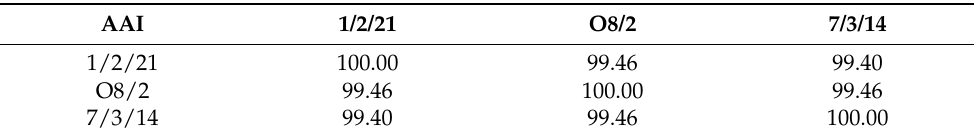
Table 4. Pairwise Average Amino Acid Identity (AAI) analyses for completely sequenced R. solani AG1-IB